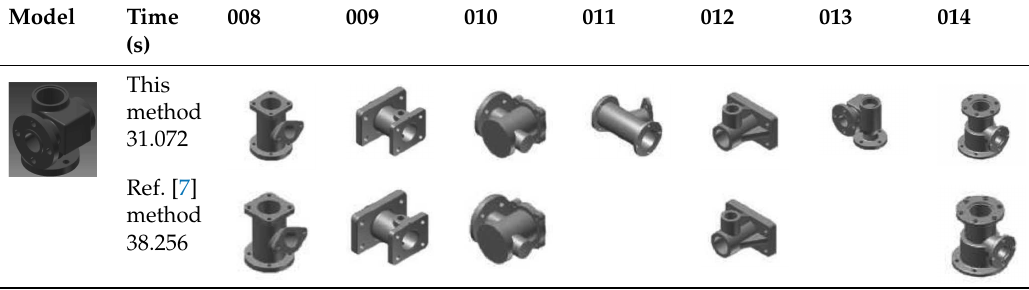
Table 15. The parts and time consuming that are similar to the model in the model base(II).